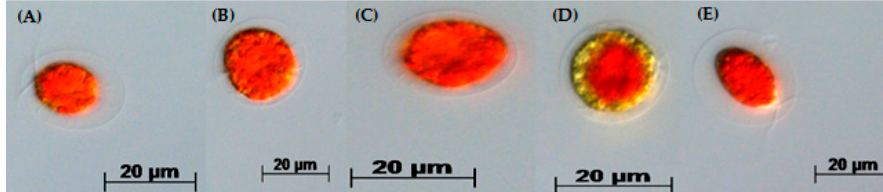
Figure 3. H. pluvialis red motile macrozooids formed in the red stage after 12 days. H. pluvialis cultures from the green stage were re-suspended from ( A ) 3N-BBM+V; ( B ) 3N-BBM+V + 10 mM SA; ( C ) FM:FB; ( D ) BG-11 and ( E ) EG:JM, then incubated under medium without nitrate (20 °C, continuous light at 240 µ mol photons m − 2 · s − 1 ). Pictures were taken with an Axio Imager 2 microscope with an Axiocam HRc.